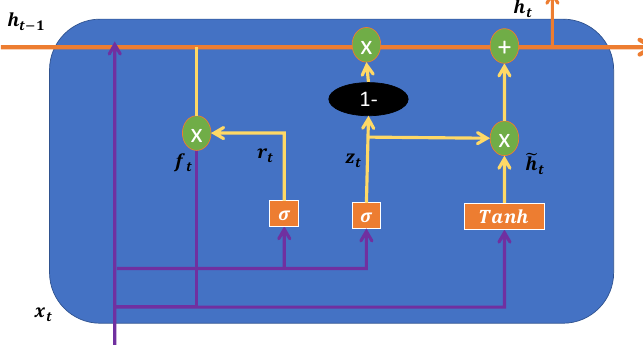
Figure 6. Architecture of a GRU unit; adapted from